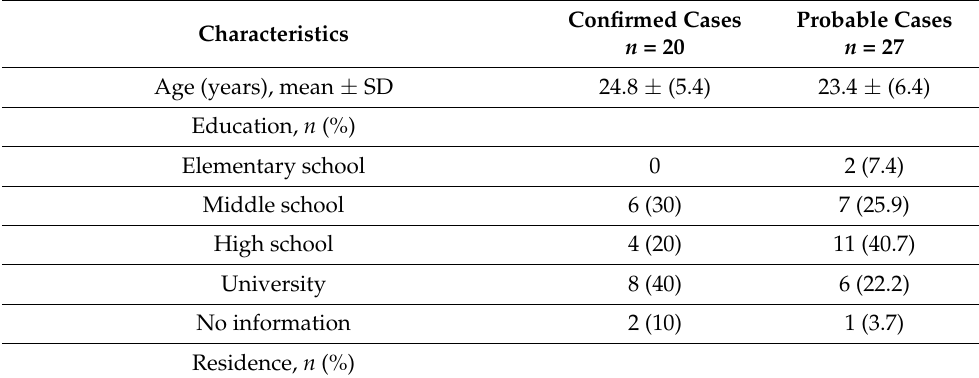
Table 1. General characteristics of mothers during pregnancy and of the infant at birth for confirmed and probable cases of